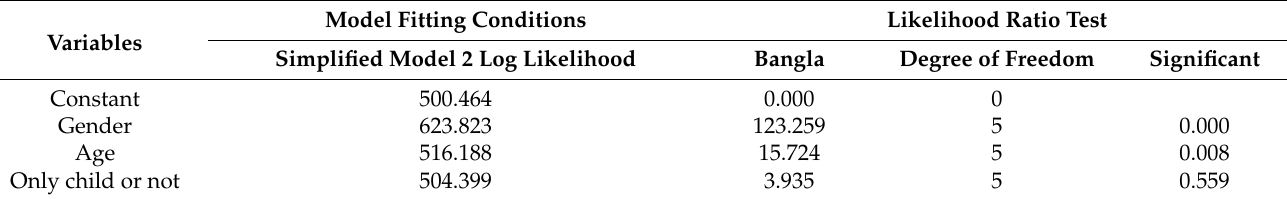
Table 5. Likelihood ratio test for independent variables.